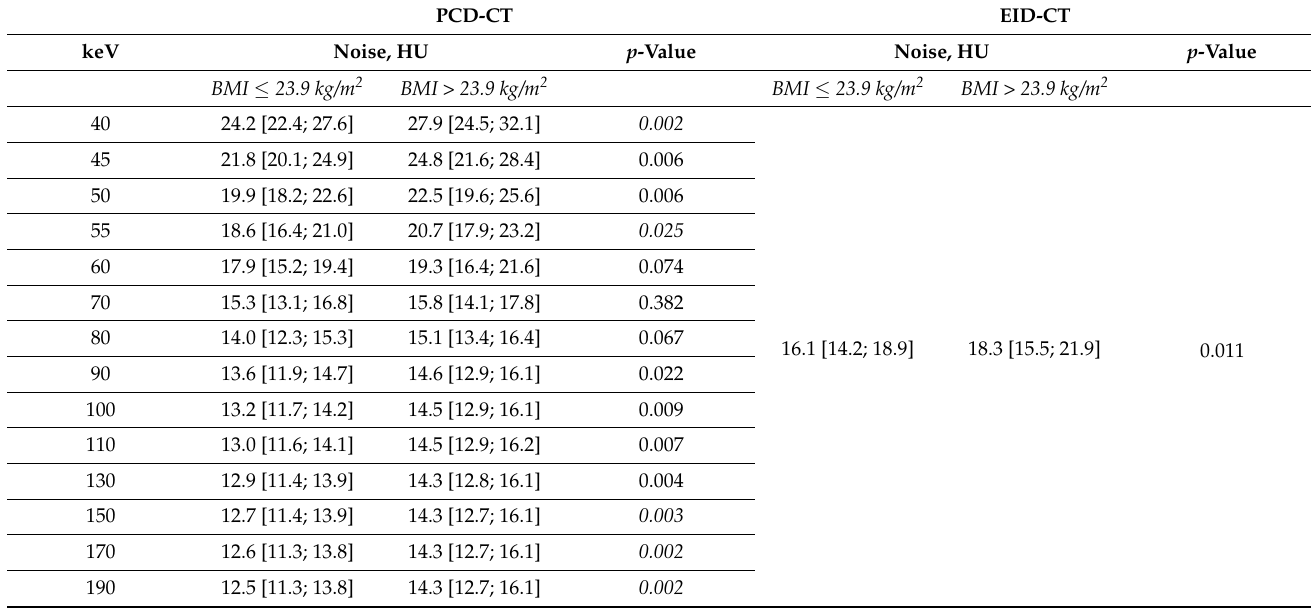
Table 3. Image noise at different keV levels in BMI-subgroups after median split.